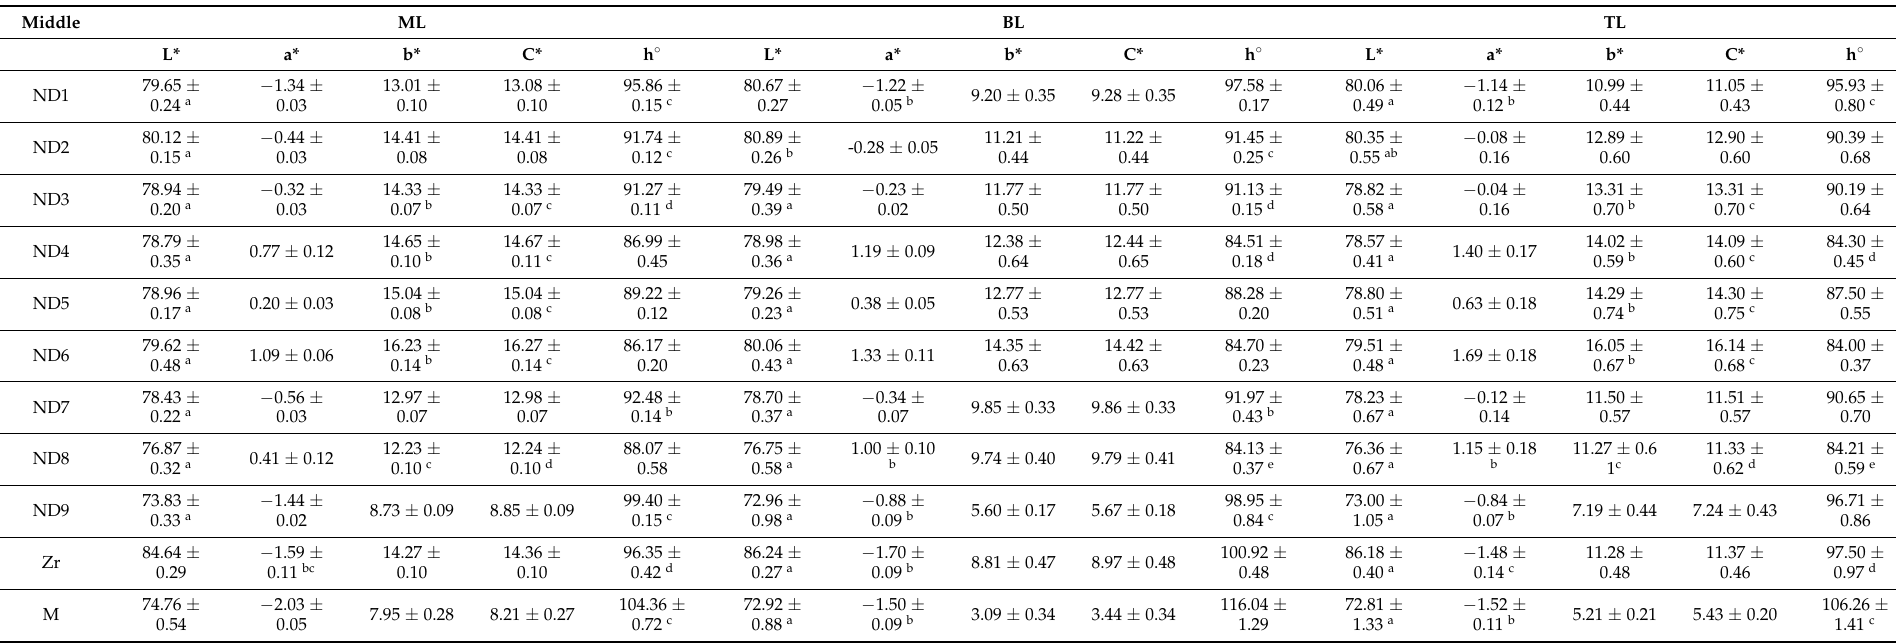
Table 2. Mean values and standard deviation of CIE L*, a*, b*, C*, and h ◦ color coordinates of zirconia crowns on different substrates evaluated for the middle